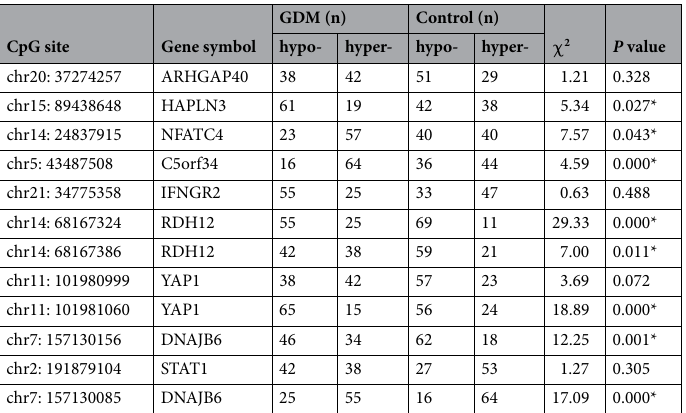
Table 4. Distribution of DNA methylation at CpG sites between GDM group and control group. * P < 0.05; hypo-, hypomethylation; hyper-,